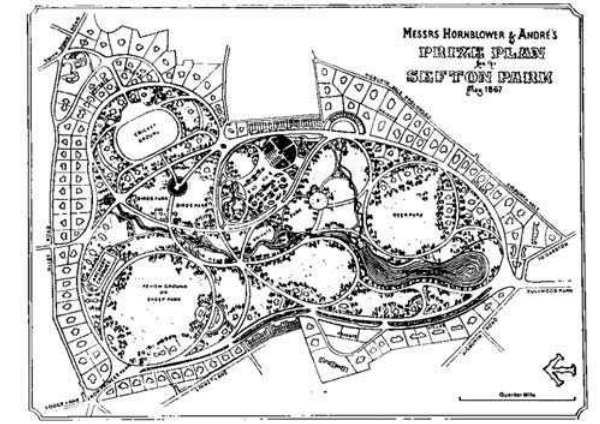
Fig 2. Lentvaris manor house – distinct accent of homestead and park